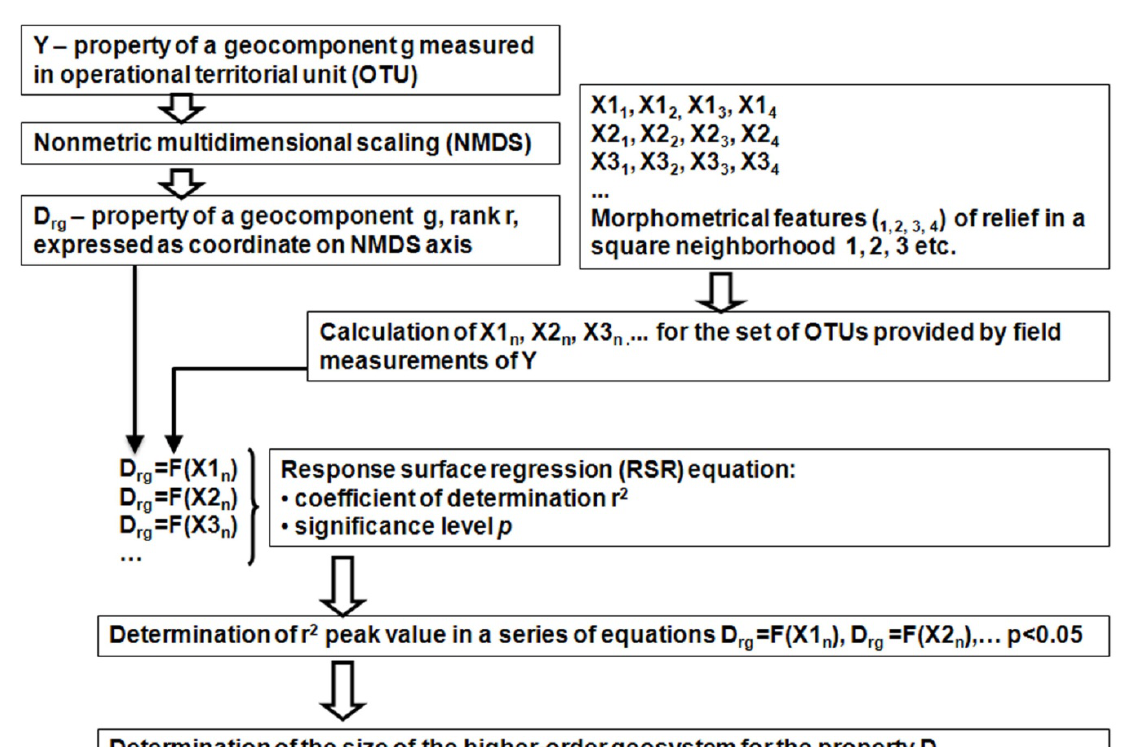
Figure 2: Procedure for determination of relevant size of the higher-order geosystems that control spatial variability of a geocomponent property. The value of property is measured in operational territorial unit (OTU) and expressed as coordinate on the axis of multidimensional scaling